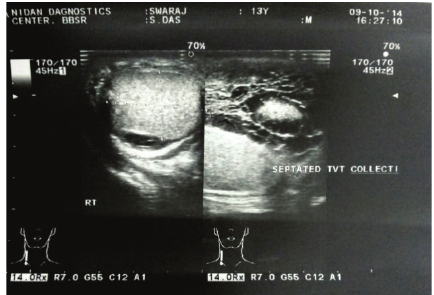
Figure 1: Septated collection.